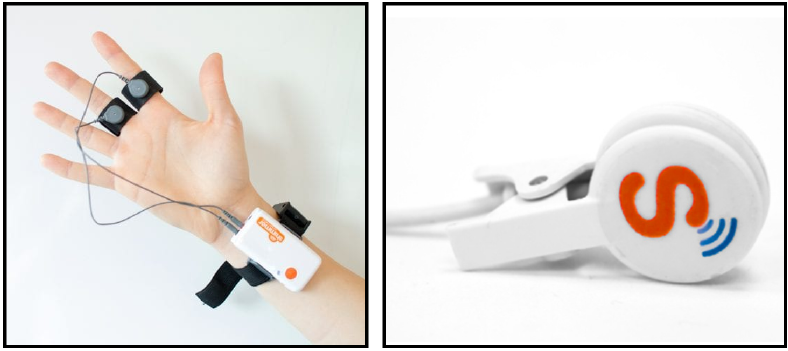
Figure 1. Sensors used to collect physiological data in the CLAWDAS dataset.